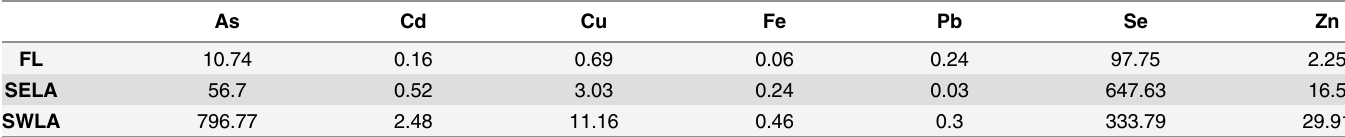
Table 7. Ratio of bioaccumulation levels (Cparasite/Chost) between alligators and their parasites collectively among geographic zones. High ratios are indicative of acute exposure to heavy metals, and low ratios are indicative of chronic exposure to heavy metal pollution.